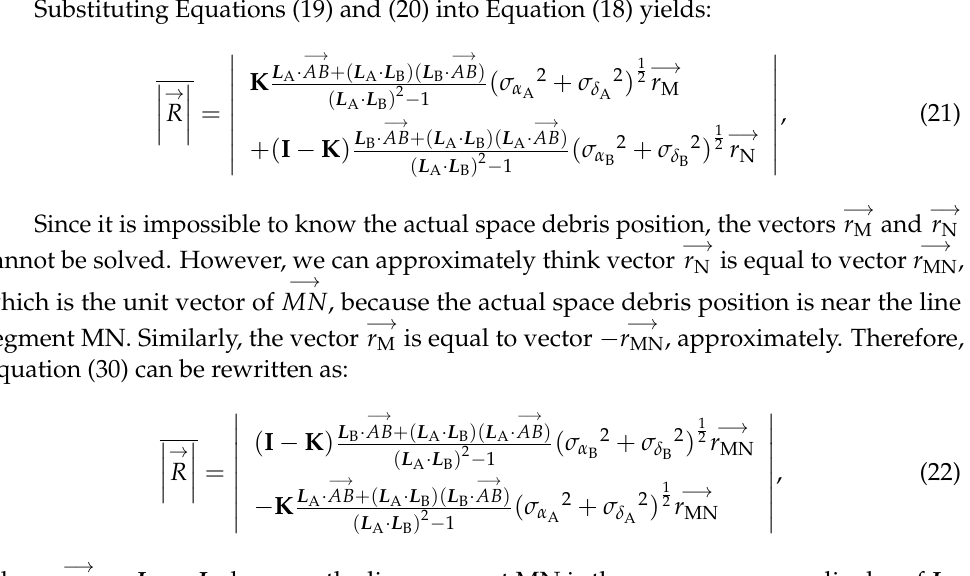
Figure 3. Error analysis of triangulation.